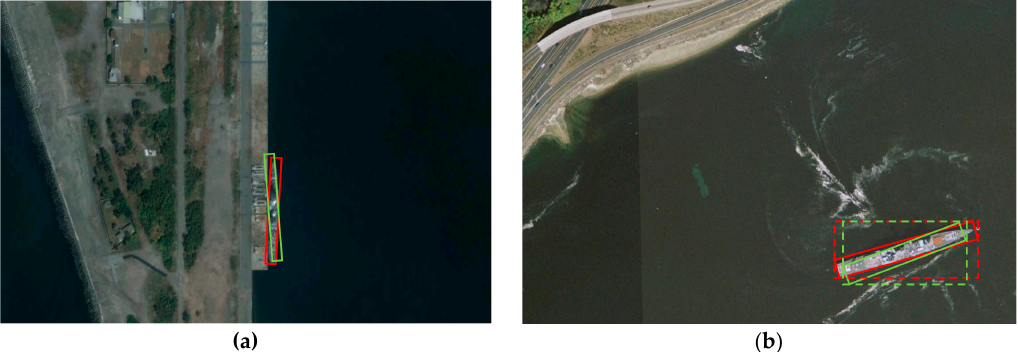
Figure 11. The sensitive relationship between IoU overlap and ship angle. The red box is the ground-truth, and the green box is the test result. ( a ) Misjudged due to low IoU; ( b ) New evaluation criteria . Through this new evaluation criteria, we can recalculate the indicators, as shown in Table 3. We can see that Recall and Precision in the rotation region method all show an obvious improvement.